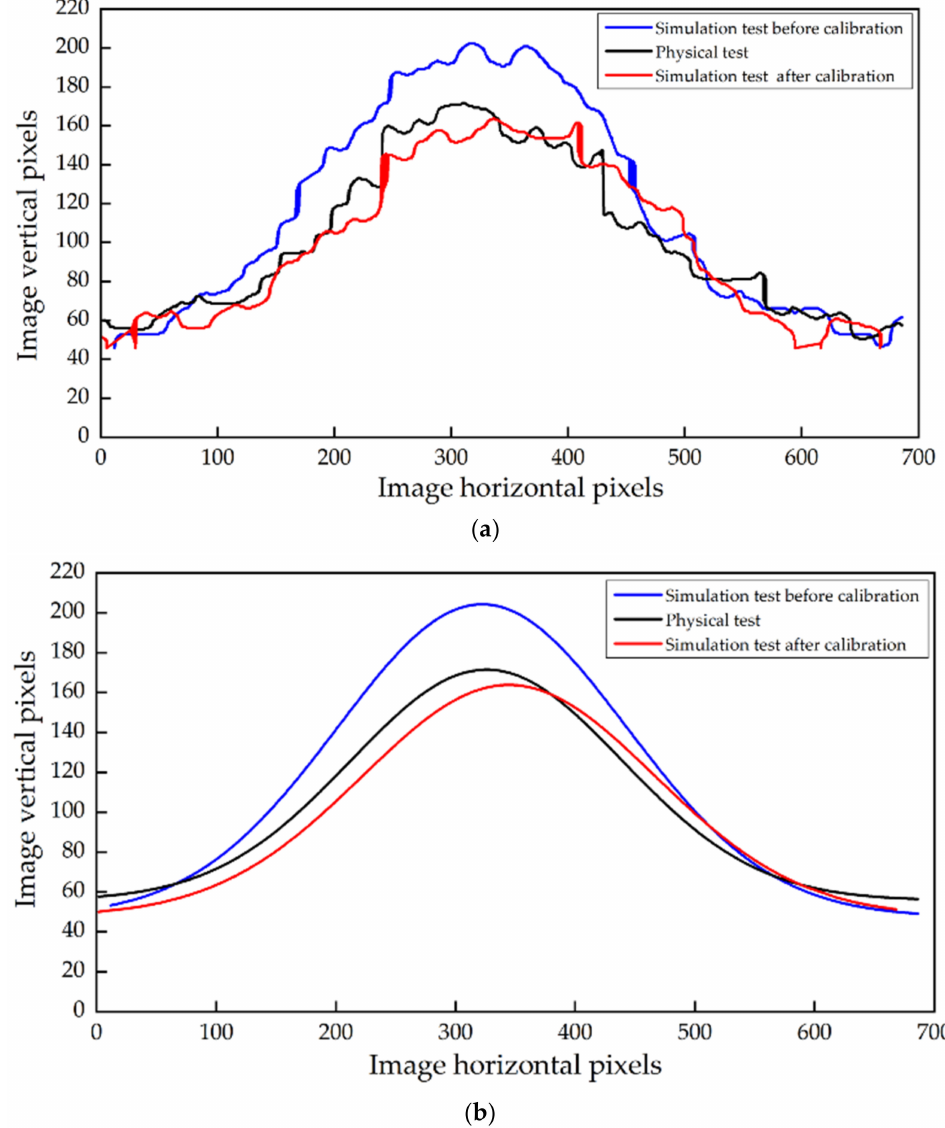
Figure 15. Comparison of the simulated and actual SMR stack. ( a ) Contour comparison; and ( b ) fitted curve